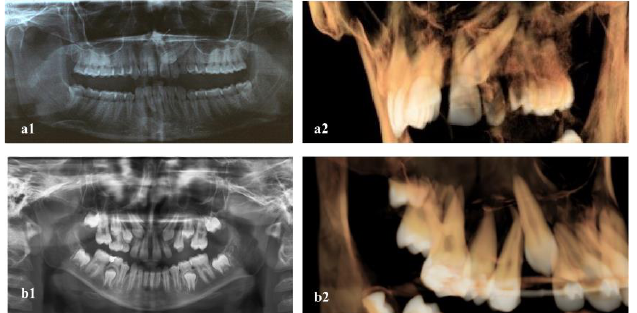
Figure 1. Panoramic and CBCT imaging of the two patients presenting palatally impacted canines (( a1 , a2 ): patient 1, ( b1 , b2 ): patient 2).